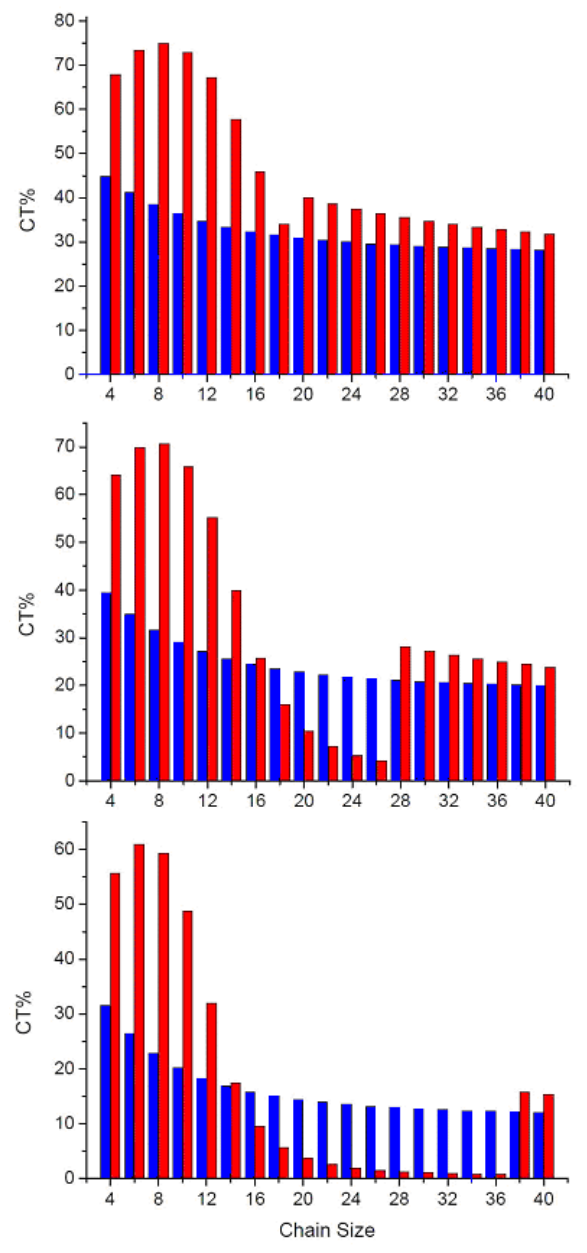
Figure 3. Dependence of the CT wave function (percentage) of lowest excited-state (blue) and second excited-state (red) as a function of chain size, with interchain distance d = 3.6 Å (upper), 3.8 Å (middle), 4.0 Å (lower), calculated by the CM model [46]. Reproduced with permission from American Chemical